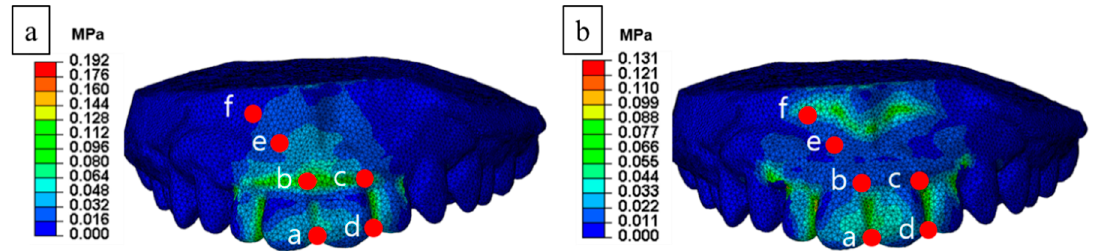
Figure 4. Stress distribution from FE analysis: ( a ) conventional and ( b ) proposed MAD.